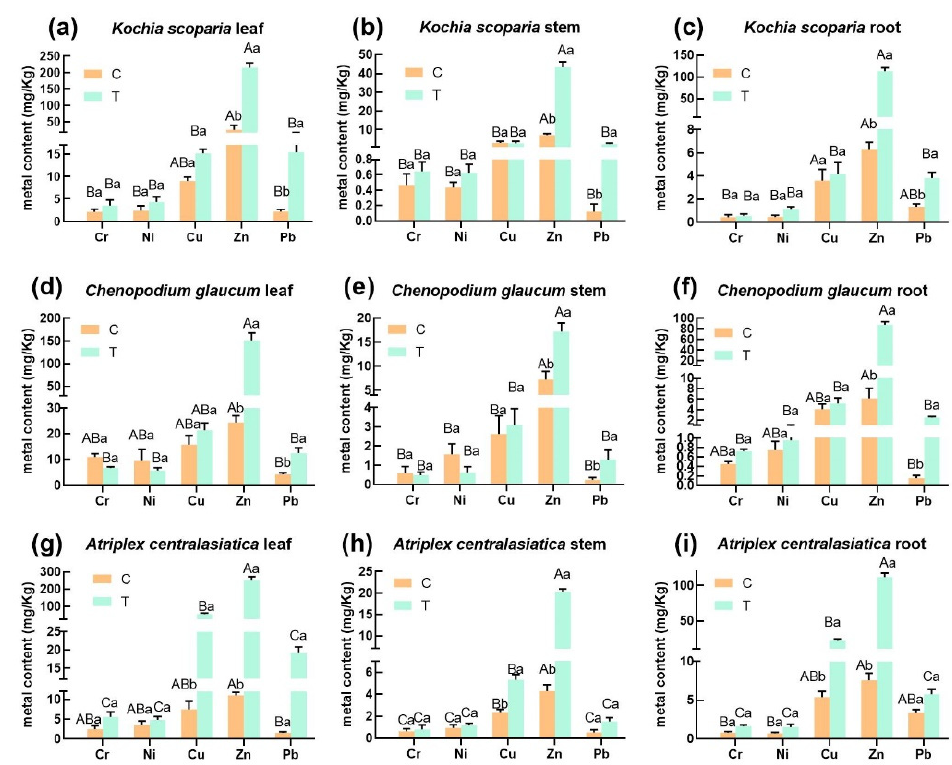
Figure 1. Five heavy metal contents in leaves, stems, and roots of three plant species. Bars indicate mean ± SD ( n = 3). Different capital letters indicate significant differences between groups (between different plants) and different lowercase letters indicate significant differences within groups (control and treatment of the same plant) using the Tukey test ( p < 0.05). C represents the control group; T represents the experimental group.